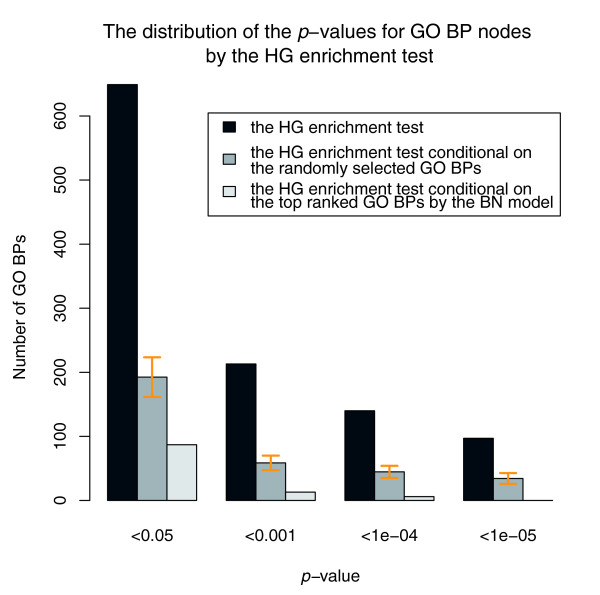
The distribution of p-values for the enrichment of cancer genes for GO BP nodes, by the HG enrichment test, the HG enrichment test conditional on the 27 CAN-processes prioritized by the BN model, and the HG enrichment test conditional on the same number of randomly sampled GO BP nodes with similar size. The error bars stand for the standard deviation of the corresponding quantities.